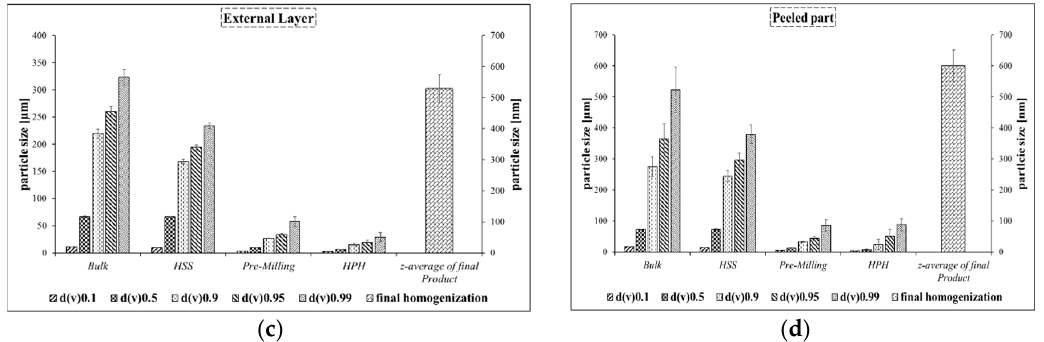
Figure 3. Microscopic images ( a ) and laser diffraction and photon correlation spectroscopy analysis of particle suspensions obtained from the whole plant (WP) of Cynomorium ( b ); the external layer (EL, ( c )) and the peeled part ( d ). High speed stirring (HSS); High pressure homogenization (HPH). Scale bar for microscopy ( a ): 100 µm.